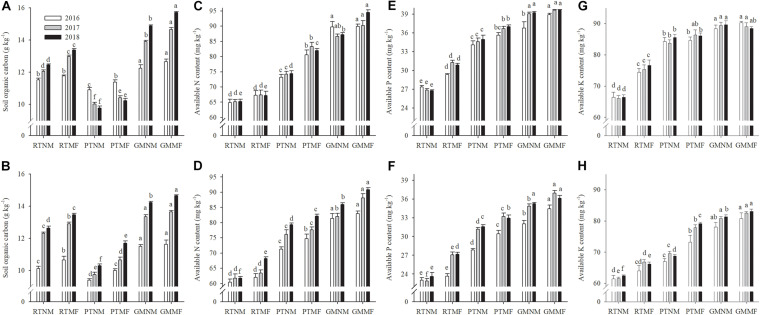
Effects of soil tillage managements and mulching film on soil organic carbon (A,B), available N content (C,D), available P content (E,F), and available K content (G,H) in the two layers. Vertical bars represent standard error (SE). Mean values ± SE (n = 3). Different letters indicate significant differences among each treatment, P < 0.05.